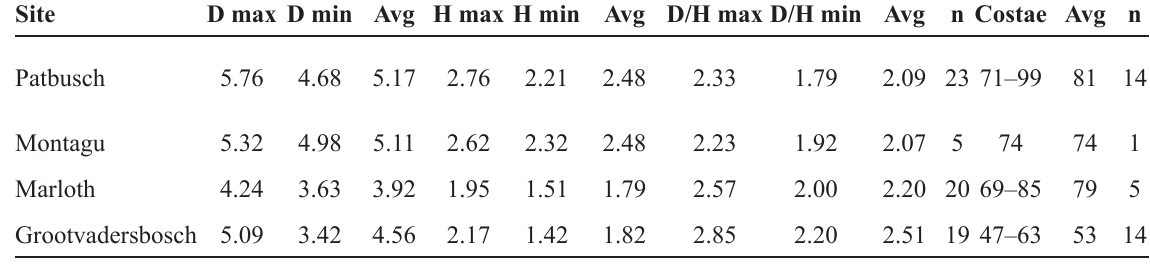
Table 3. Measurements of Chondrocyclus langebergensis sp. nov., showing variation between populations; D = shell diameter, H = height, costae = number of axial ribs on body whorl, Avg = average.